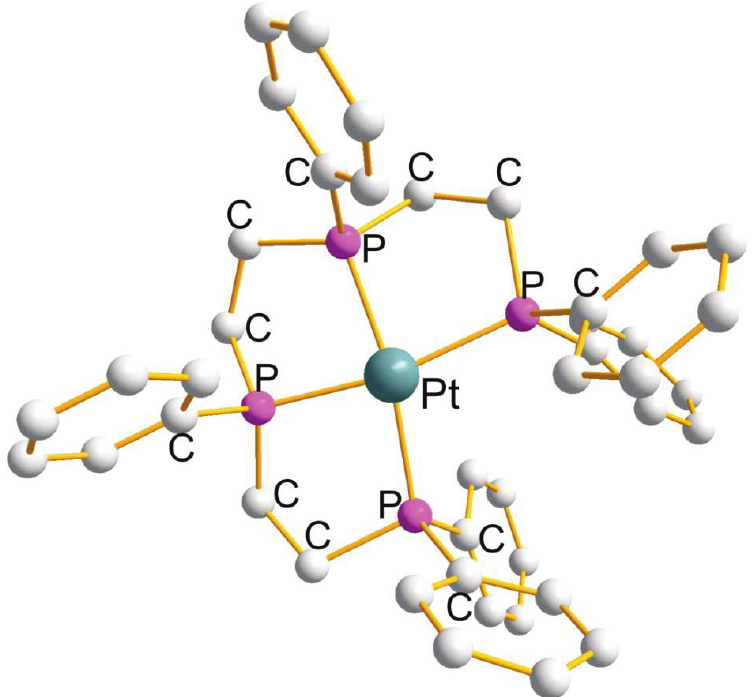
Figure 4: Structure of [Pt{ η 4 -C